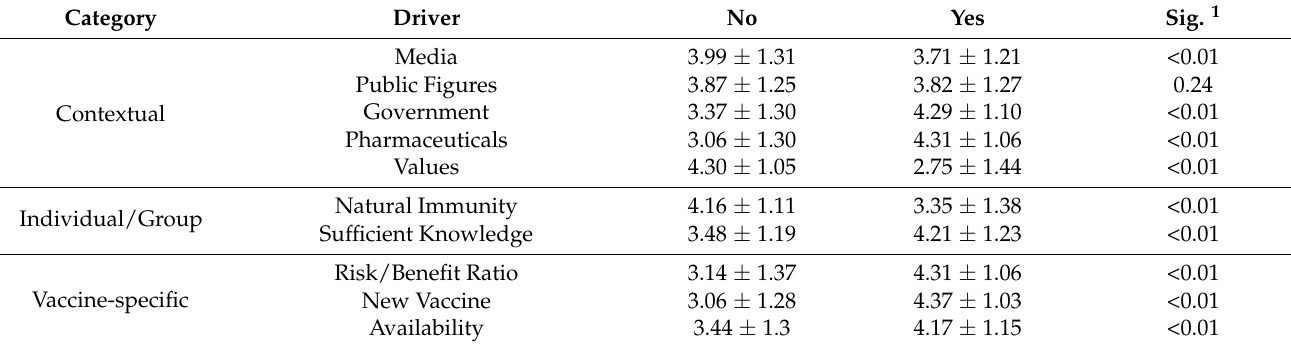
Table 8. Drivers of dental students’ COVID-19 vaccine acceptance worldwide, February